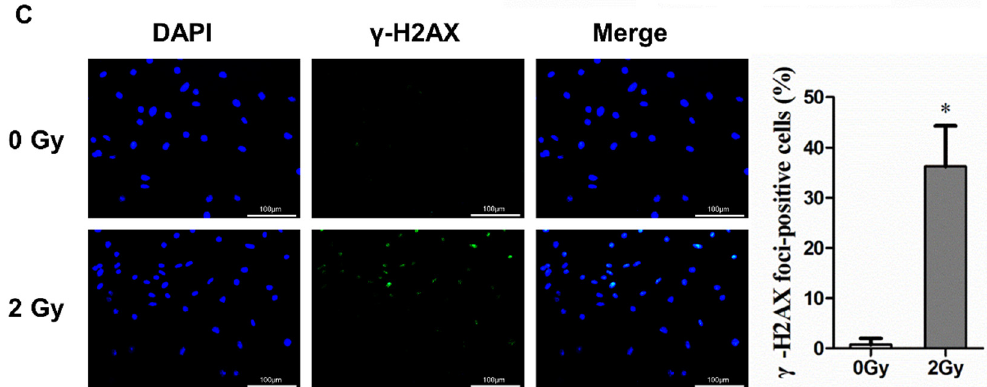
Figure 2. Radiation-induced cellular senescence and DNA damage in osteocyte-like MLO-Y4 cells. ( A ) Cells were stained with DAPI to observe SAHF formation; magnification = × 200. SAHF was examined in a total of four individual visual field images from each group. ( B ) Expression of p21 and p16 mRNA and proteins detected by RT-qPCR and Western blot analysis; n = 3. ( C ) Representative images of the γ -H2AX immunofluorescence staining (green) and nuclei (blue) of the irradiated MLO-Y4 cells; magnification = × 200. Percentage of γ -H2AX-foci-positive cells and the quantification of γ -H2AX foci in four separate visual field images for each group. Results are expressed as mean ± SD (* p < 0.05; ** p < 0.01; *** p < 0.001 vs. 0 Gy).